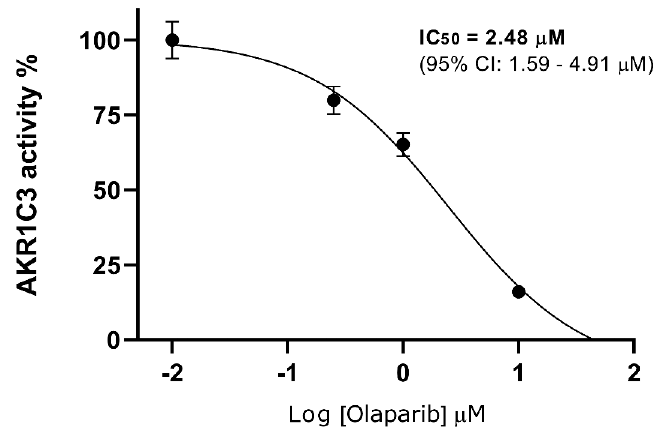
Figure 2. IC 50 (half-maximal inhibitory concentration) of AKR1C3 inhibition by olaparib. Data are expressed as the mean ± SD from three independent assays.